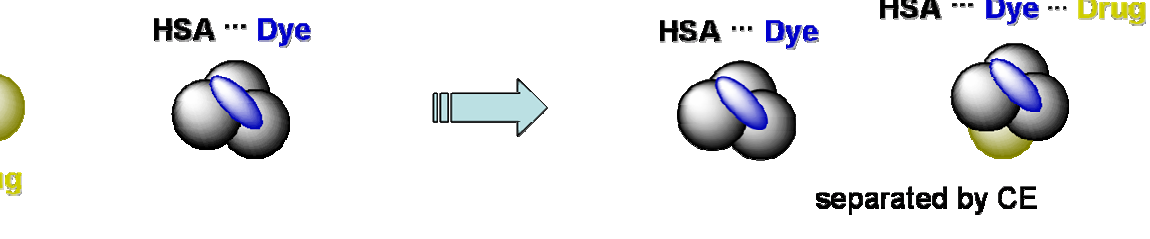
Figure 2. Illustration of noncompetitive binding of the drug and dye with HSA.